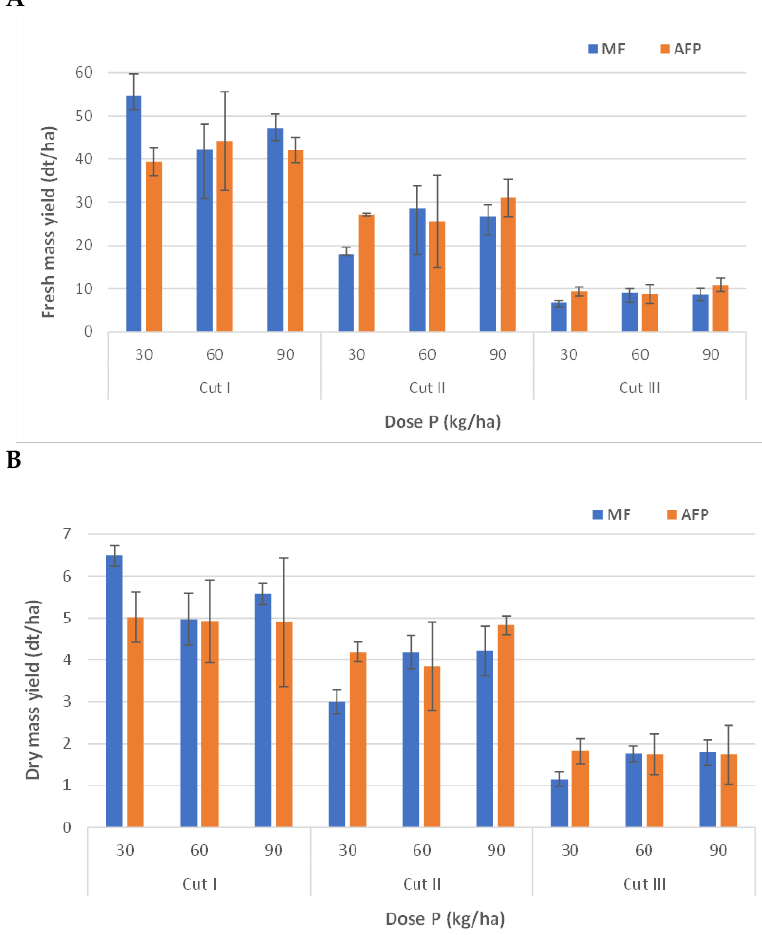
Figure 2. Yield of ryegrass mass depending on the cut and the type and amount of fertilization (( A ) — fresh mass; ( B ) — dry mass). MF — mineral fertilizer; AFP — hydrogel capsules with adsorbed P; dt/ha — decitonne/hectare.